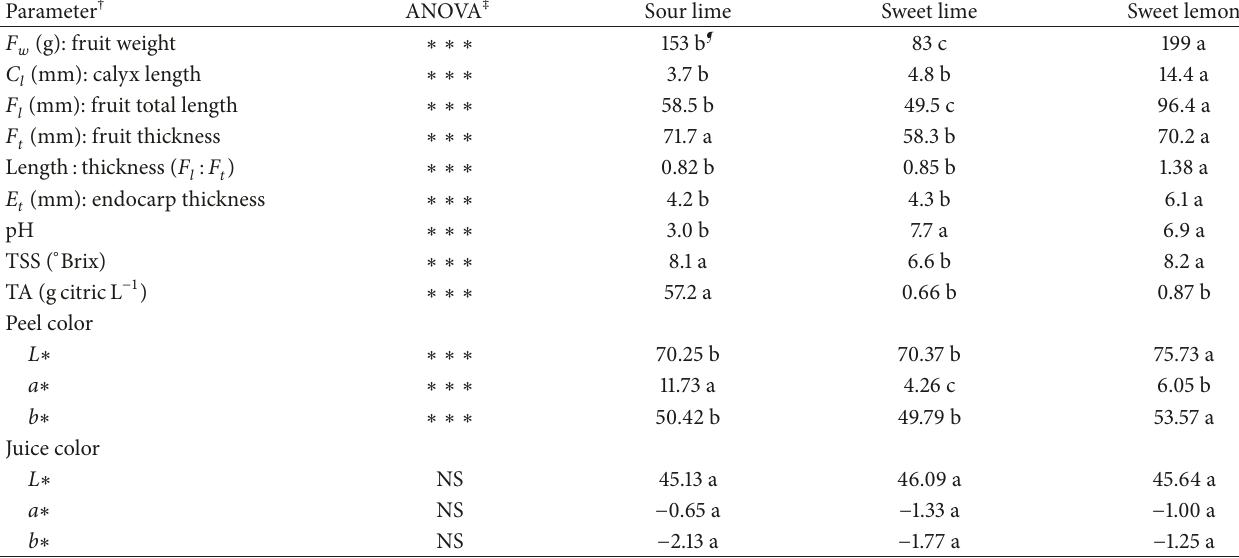
Table 1: Morphological and physicochemical parameters of endangered Spanish lime and lemon samples.